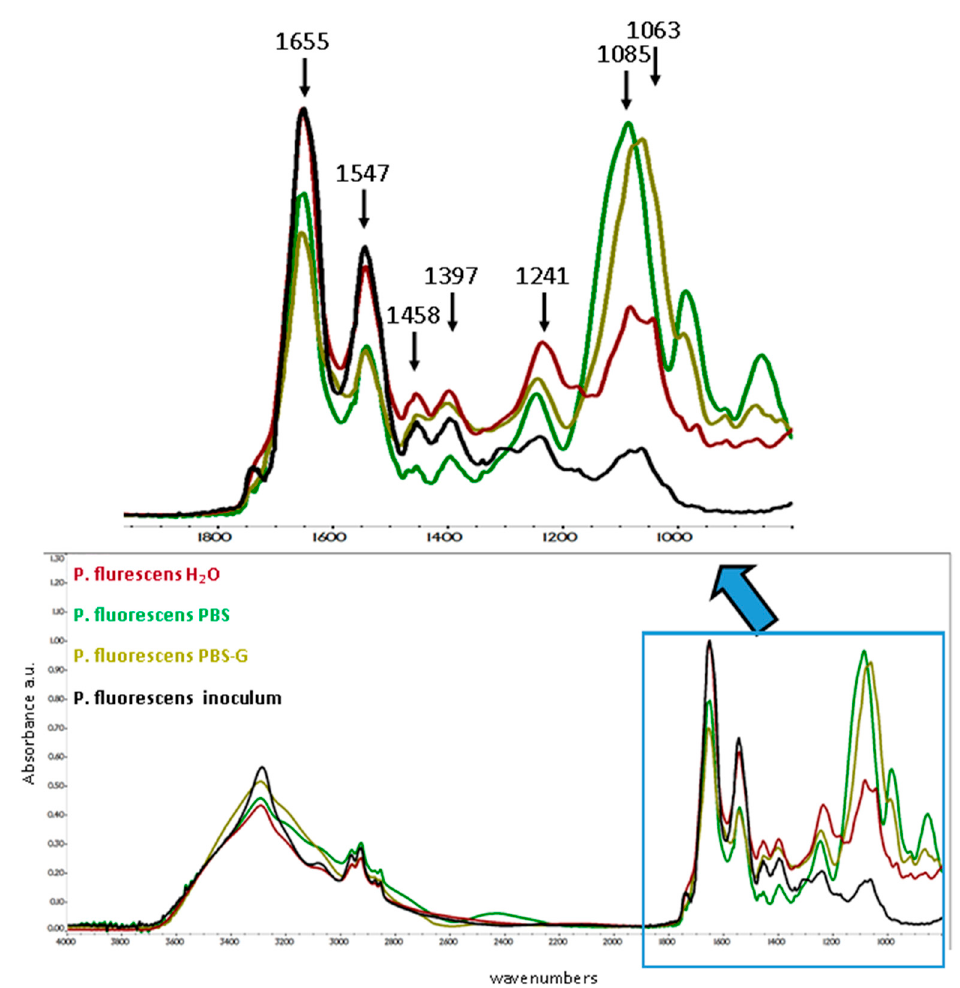
Figure 6. FTIR spectra of P. fluorescens after 180 min in H 2 O, PBS, and PBS-G compared with inoculum.